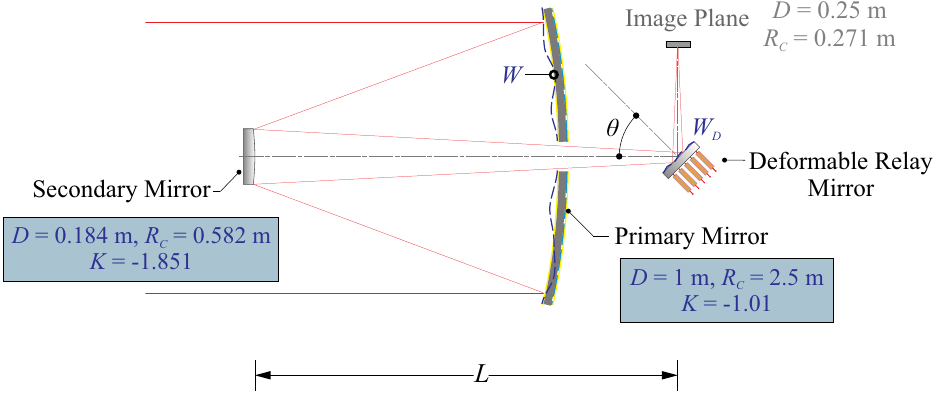
Figure 11. A Ritchey–Chrétien (R-C) design of space telescope: a relay mirror is added to fold the optical path; both primary and relay mirrors are deformable ( L = 1.4 m, θ = 45 ◦ ). The shape deviation of the primary mirror (thin-shell reflector) is set to be W = ∑ a i Z i at the entrance pupil, and the deformable relay mirror with a shape of W D = ∑ b j Z j is used to compensate the wavefront error of the aberrated primary. Both surfaces are